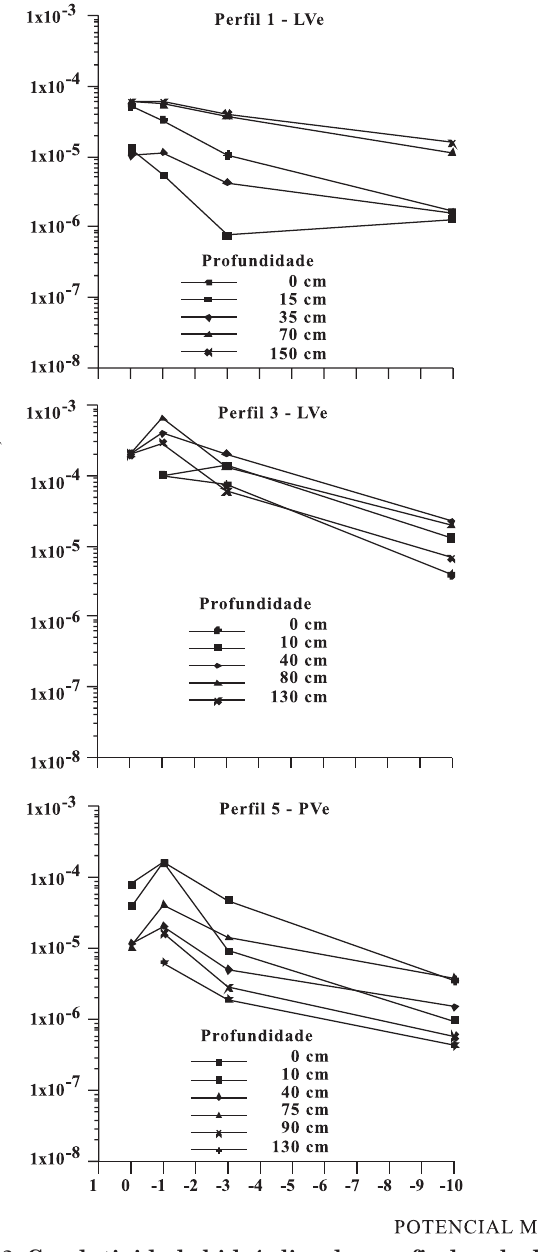
Figura 2. Condutividade hidráulica dos perfis de solo da toposseqüência Campus do